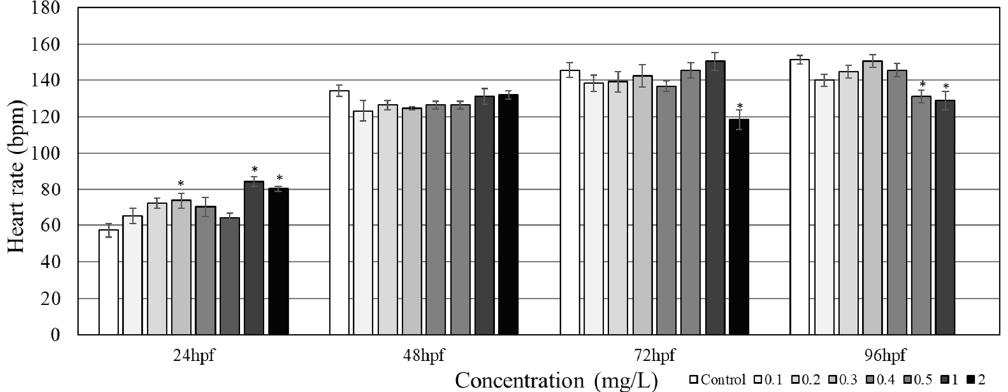
Figure 3. Heart rate of zebrafish embryos/larvae at 24 hpf, 48 hpf, 72 hpf, and 96 hpf under PHMG-P exposure ( N = 5). Asterisk (*) denotes statistical significance (p < 0.05).